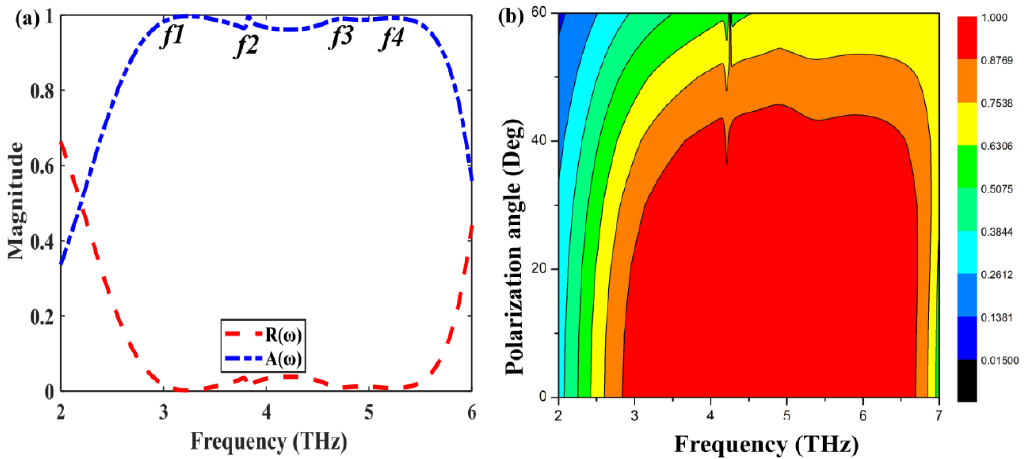
Figure 3. ( a ) Ultra-wideband absorber reflection and absorption spectra. ( b ) Polarization angle color absorption spectrum map.